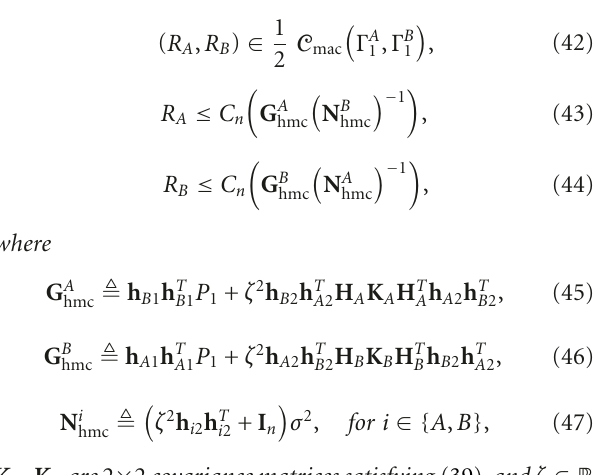
rate constraints for MAC in (22) to (24) are satisfied. This corresponds to the rate constraint in (42). Let the estimated messages from A and B be (cid:11) m A and (cid:11) m B . In the second stage, relay 1 transmits X N